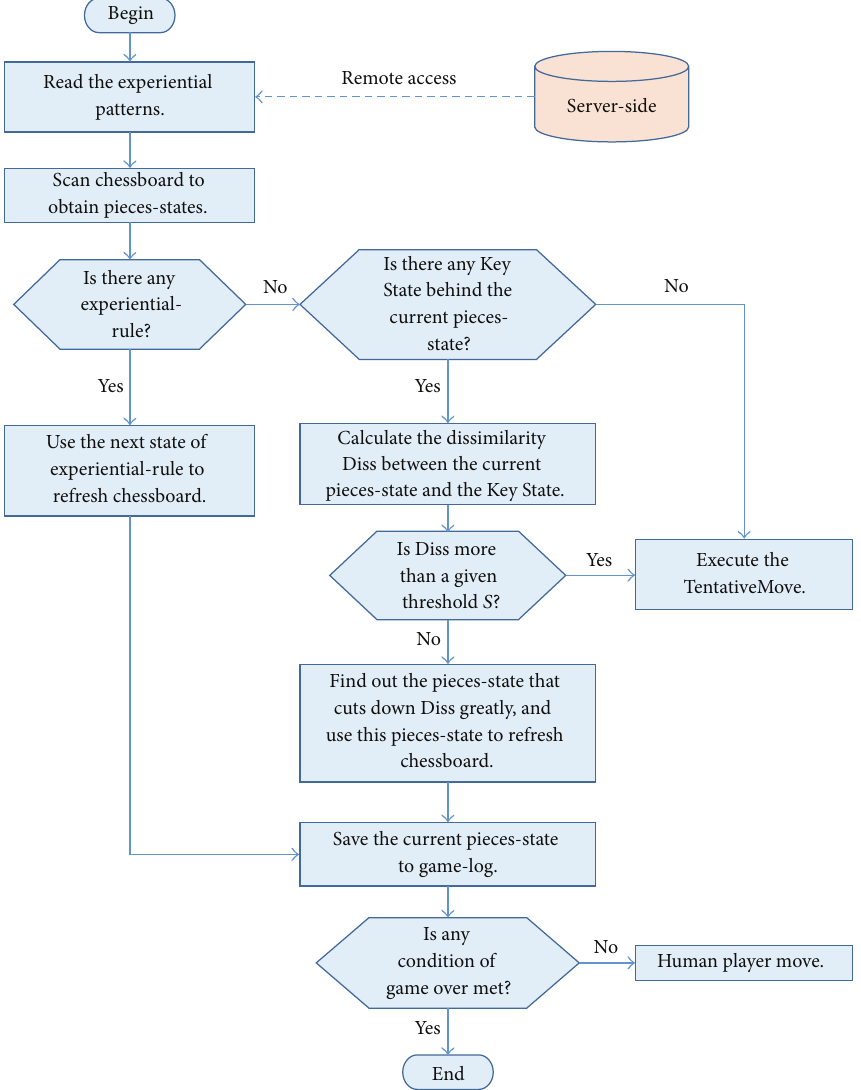
Figure 5: Strategy of the computer